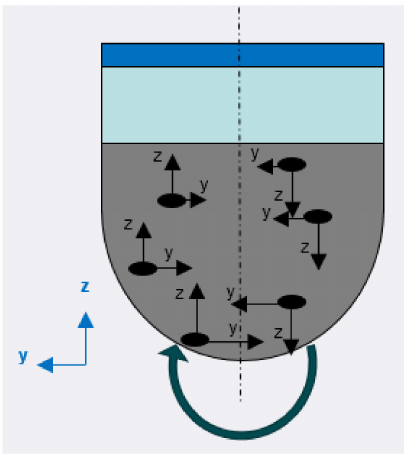
Figure 6. Impact of vibrational force exerted by the trough on a media when rotating (side view).